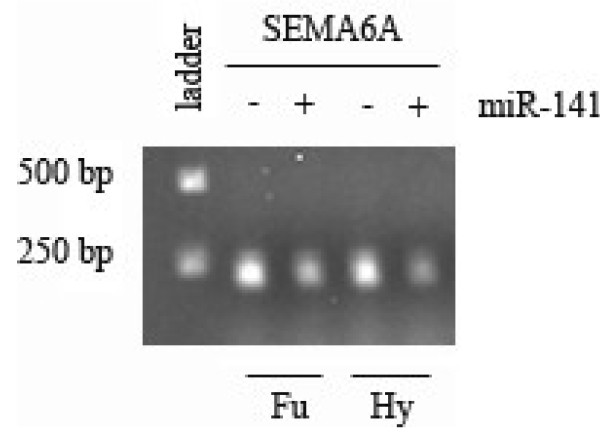
Validation of a Direct interaction between miR-141 and SEMA6A. Results of in-vitro experiment on RCC cell line CRL-1611 transfected either with pre-miR-141 or a control pre-miR using either Fugene (Fu) or Hyfect (Hy). RNA was extracted after 48 hours and the expression of SEMA6A was measured using semi-quantitative RT-PCR. There is clear reduction in mRNA of SEMA6A upon introduction of miR-141 by either transfection method in these cells.